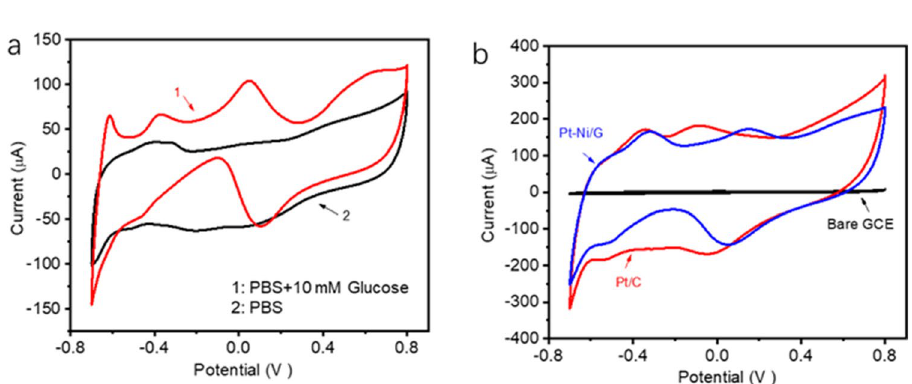
Figure 3. ( a ) CVs of PtNi alloy-graphene/GC electrode in the absence and present of 10 mM glucose in 0.1 M PBS solution at scanning rate of 10 mV/s; ( b ) CVs of PtNi alloy-graphene/GC, commercial Pt/C/GC and bare GC electrodes in 0.1 M PBS with 10 mM glucose at scanning rate of 30